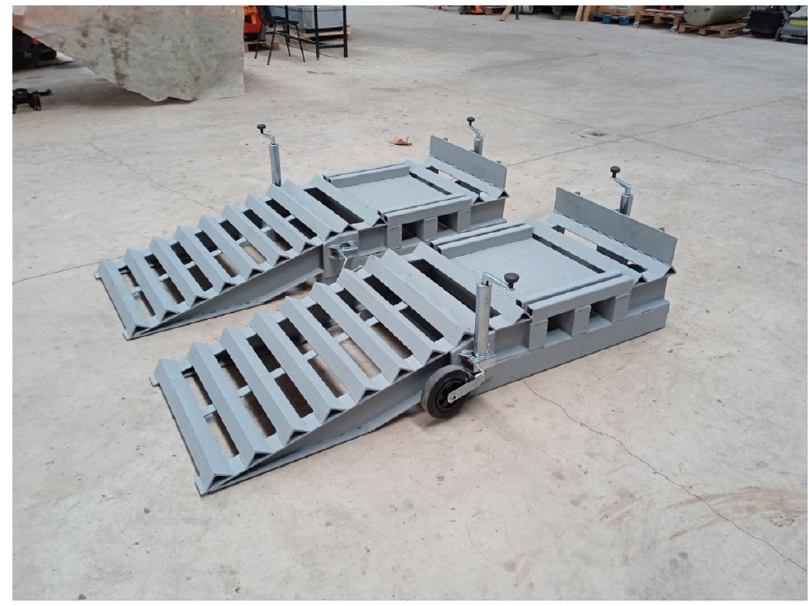
Fig. 2. Ramps on the floor without embedded scales ready to support a tractor